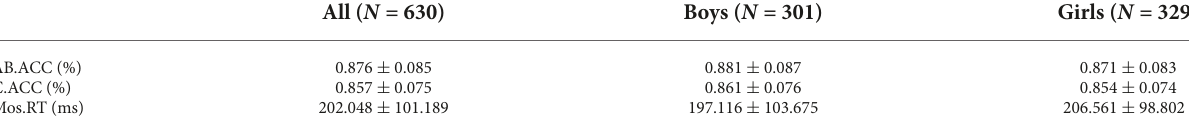
TABLE 2 The descriptive characteristics of the participants’ cognitive flexibility (Mean ± SD).